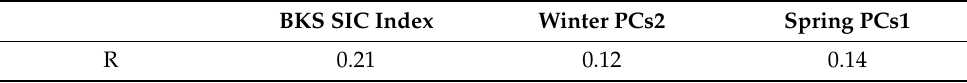
Table 1. Correlation coefficients between the spring Arctic Oscillation and the Barents–Karas sea ice concentration index, principal component time series of Eurasian snow water equivalent EOF2 in winter, and principal component time series of Eurasian snow water equivalent EOF1 in spring.